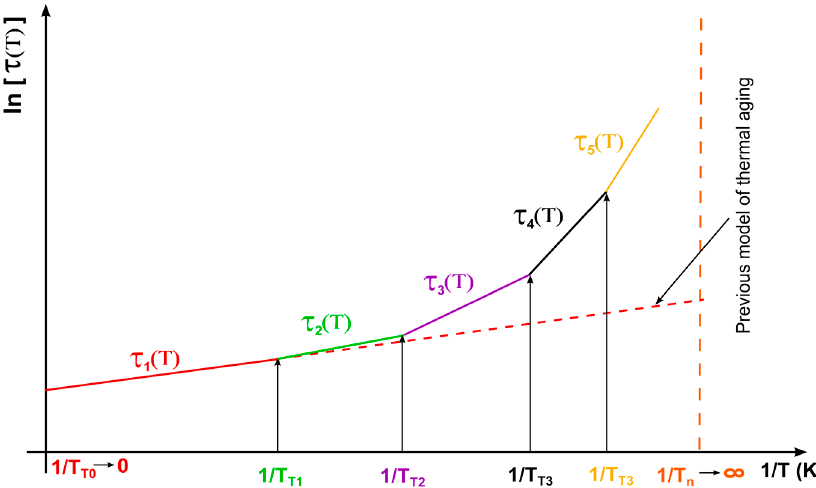
Figure 3. Graphical representation of the proposed model in logarithmic scale.